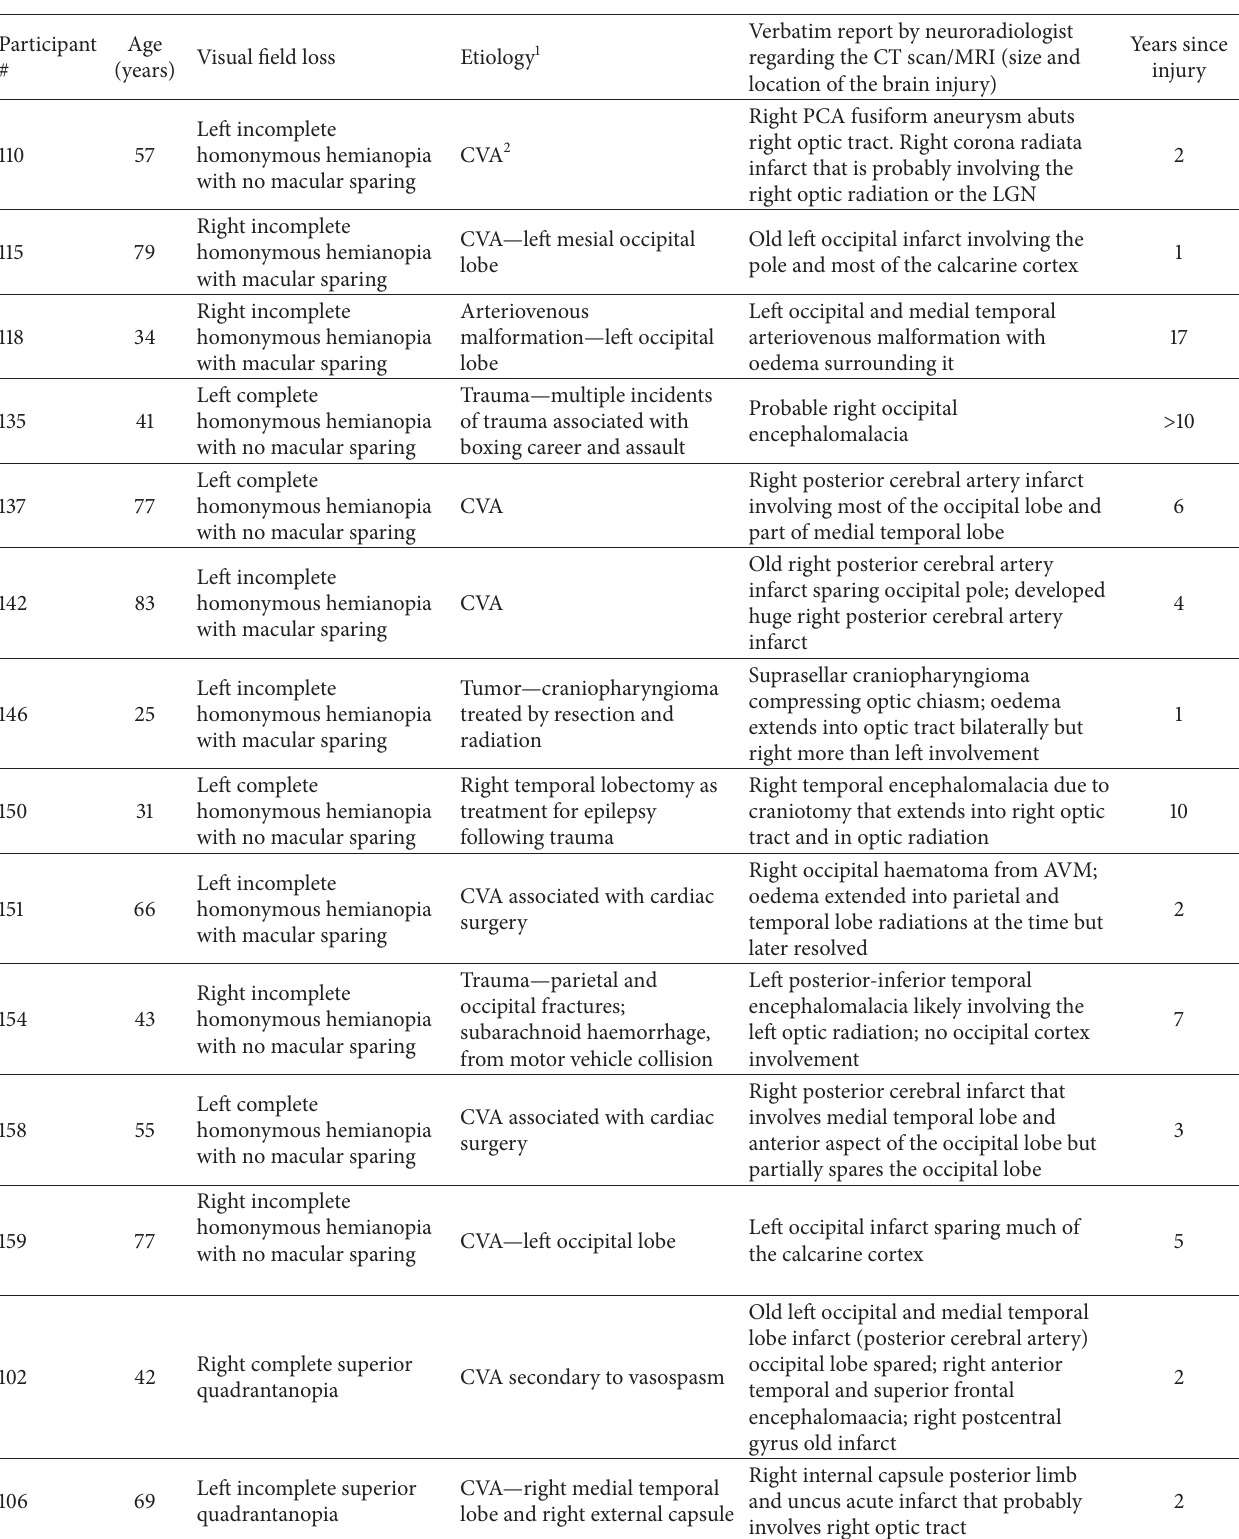
Table 1: Visual field characteristics and etiology of brain injury of the